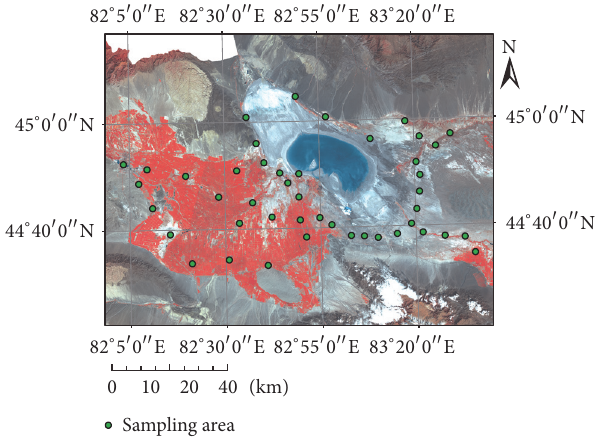
Figure 1: Study area and distribution of sampling